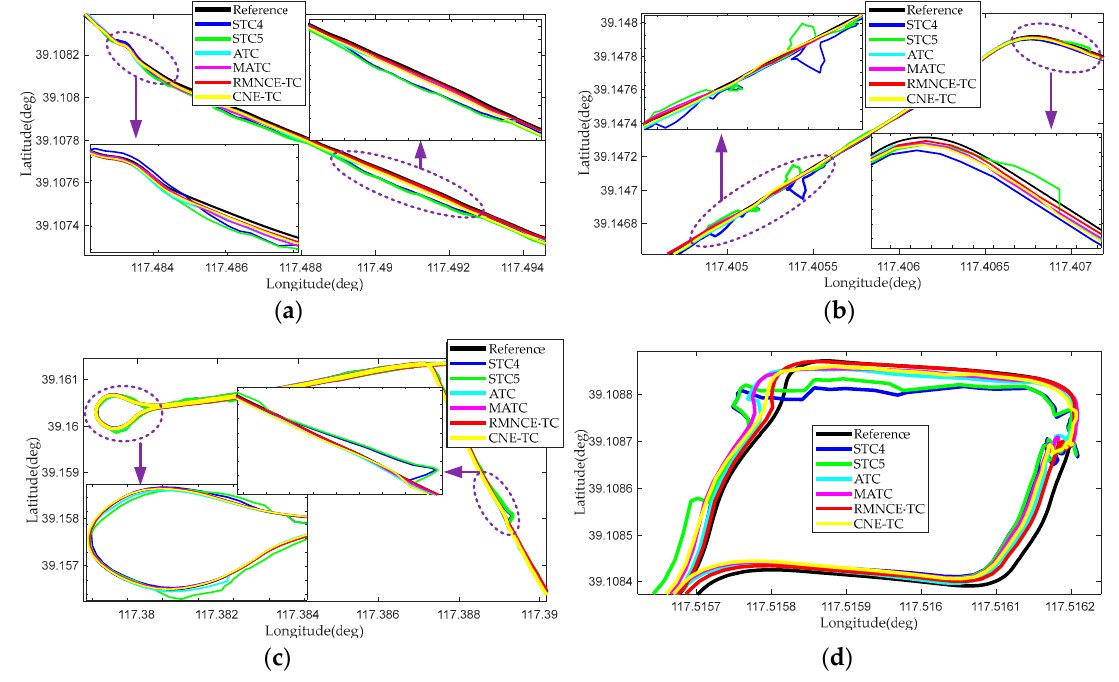
Figure 17. Local reference trajectories and those provided by different test schemes: ( a ) trajectories in segment S1; ( b ) trajectories in segment S2; ( c ) trajectories in segment S3; ( d ) trajectories in segment S4.